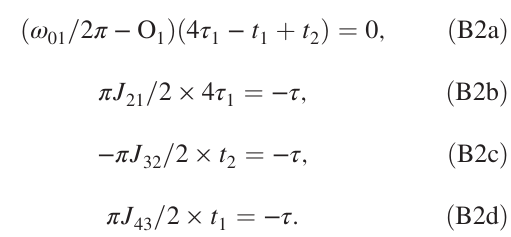
FIG. 6. (a) Quantum circuit that measures the OTOCs. The first part aims to reset an arbitrary state to the desired initial state. Here, the time interval between the π pulses is 25 ms, the number of cycles is l ¼ 500 , and G implementing the dynamics of e − i ˆ H zz τ (left) and e i ˆ H zz τ (right). The refocusing circuits are designed to generate the right amount of coupled evolution. (c) 13 C experimental spectrum for equilibrium state (blue) and state ˆ ρ 0 (red) after a readout pulse shown at the same scale for